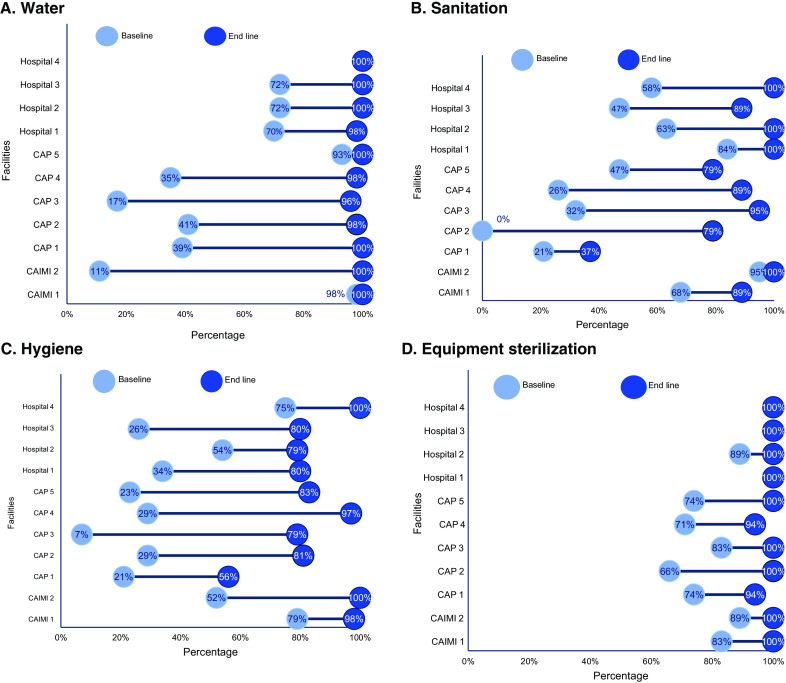
Baseline and End Line Assessment of Facility Compliance Level in Water, Sanitation, Hygiene, and Equipment Sterilization Before and After Clean Clinic Approach Intervention, by Facility (N=11)